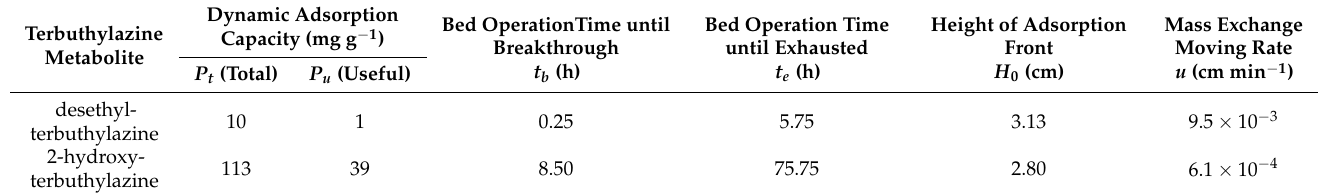
Table 6. Characteristic parameters of dynamic sorption obtained in the tested systems. Terbuthylazine